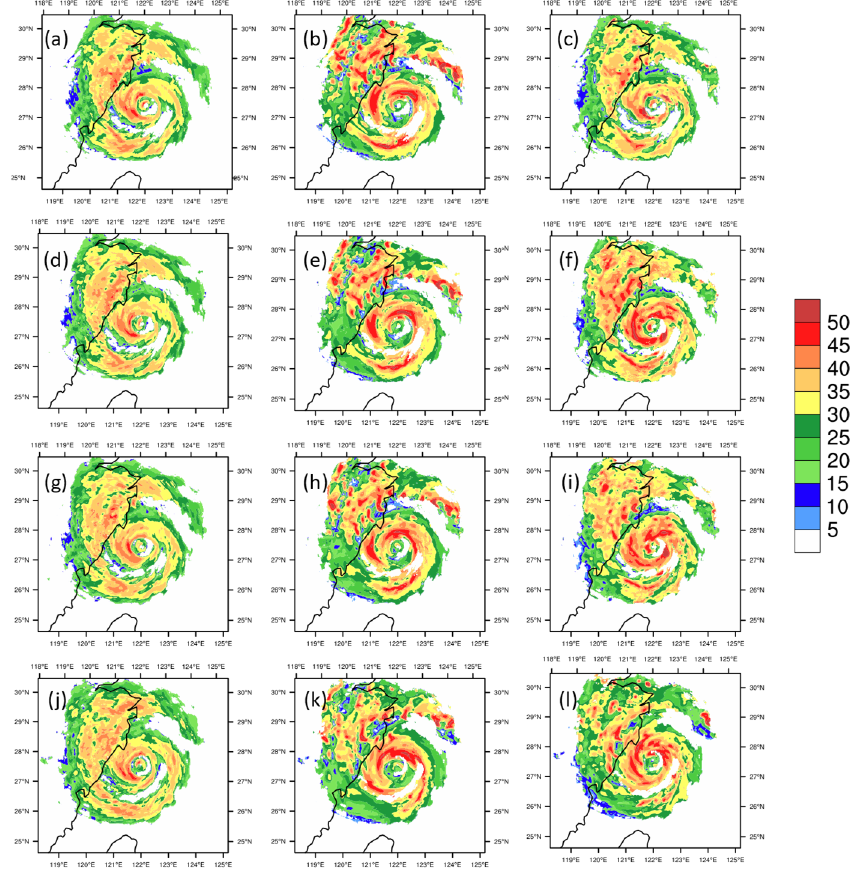
Figure 3. Composite reflectivity (unit: dBZ) for the (left) observation, (middle) CNTL, and (right) Z-DA experiments during the analysis and forecast times (from top to bottom) at ( a – c ) UTC 1200, ( d – f ) 1212 UTC, ( g – i ) 1224 UTC, and ( j – l ) 1300 UTC, 9 August